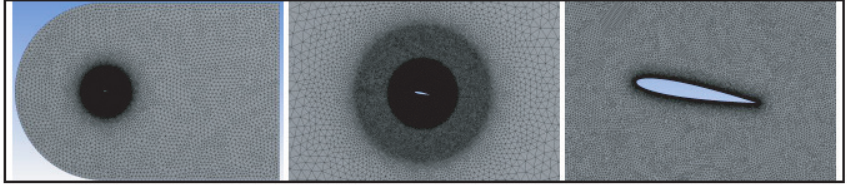
Figure 6. Mesh for airfoil.